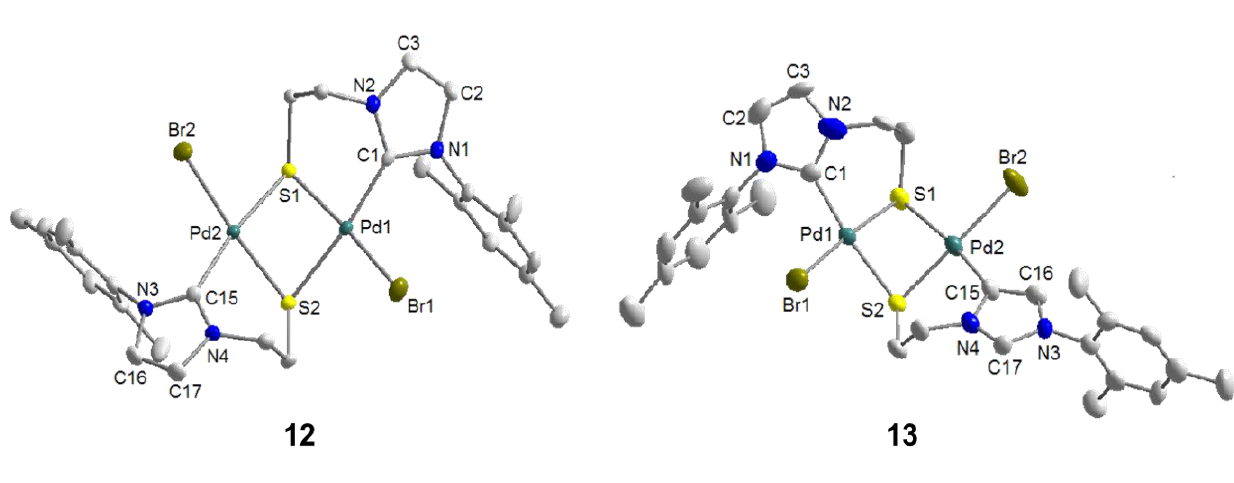
Figure 14. Molecular structures of 12 and 13